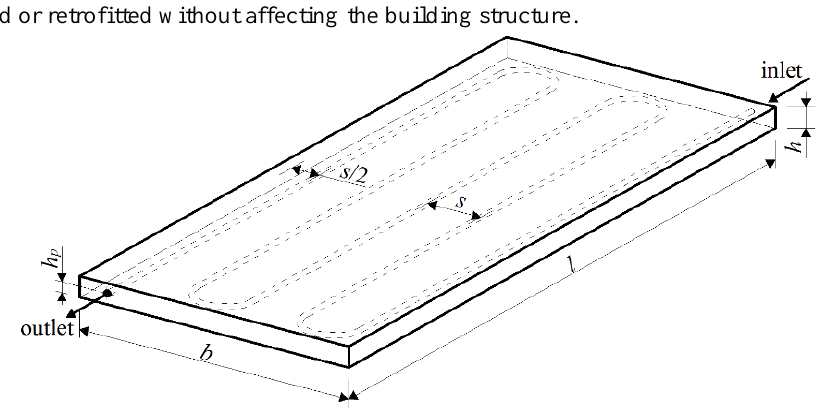
Fig. 1. Schematic representation of the PCM thermal energy storage